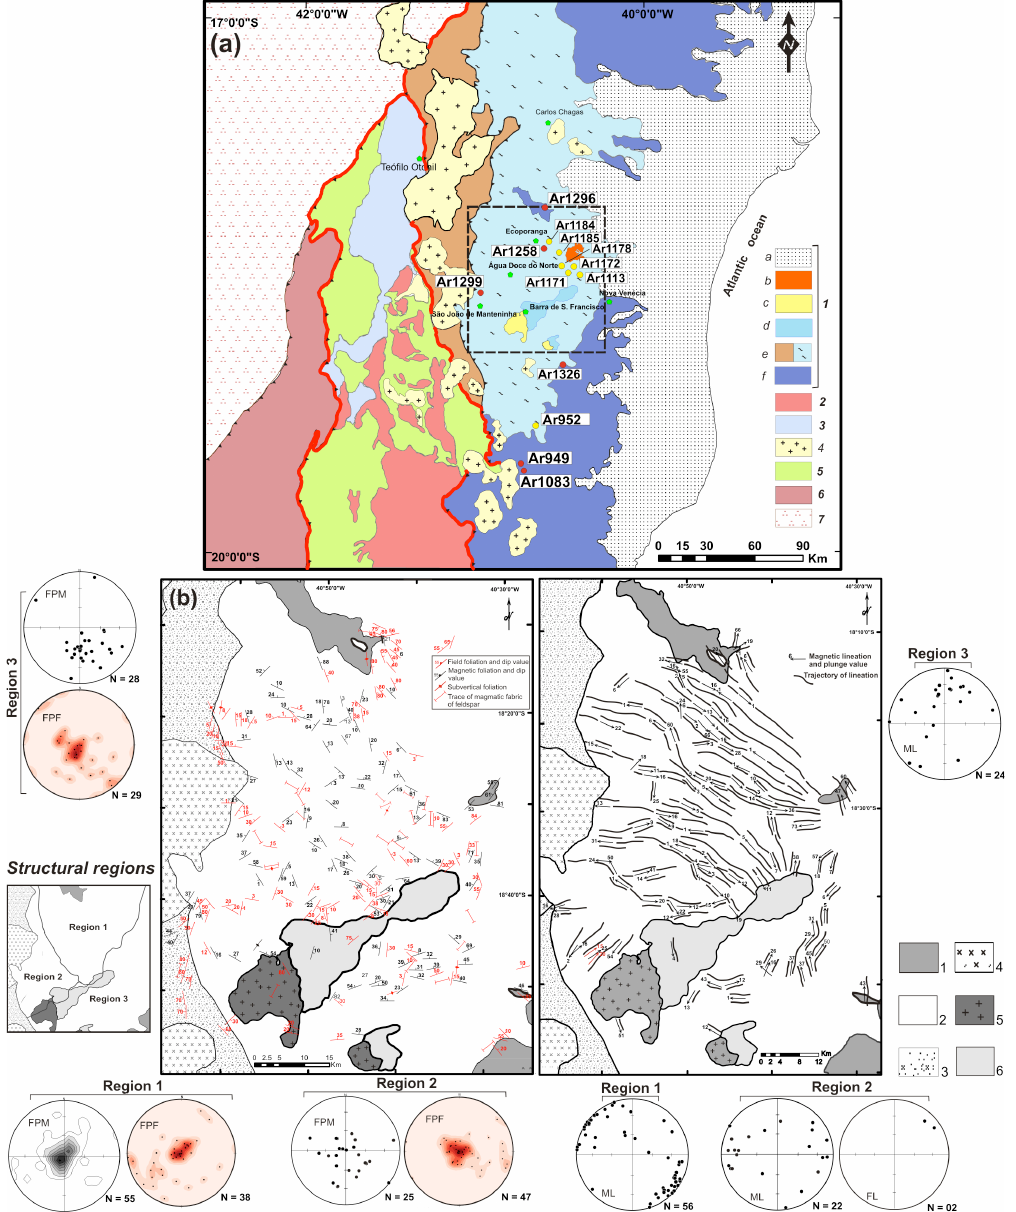
Figure 2. (a) Simplified geological map (after Oliveira et al., 2000 , and Vauchez et al., 2007) showing the main domains of the Araçuaí belt and the location of the samples selected for this study (red = samples analyzed by TitaniQ and yellow = samples of geochemistry analysis): the eastern domain (1) comprises a thick ( > 10km) layer of diatexites, metatexites and anatectic granites (e) associated with migmatitic granulites (f) and intruded on by granite (c) and charnockite (d). (a) and (b) represent the Phanerozoic cover. The central domain comprises a sycollisional magmatic complex (2 = Galiléia batholith; 3 = São Vitor tonalite) intruding in HT metasediments (5). The western domain involves HT metasedimentary mylonites injected by abundant synkinematic leucocratic magma (6) thrust upon the para-autochthonous metasedimentary cover of the São Francisco craton (7). Late orogenic ( ∼ 520Myr, Mondou et al., 2012) porphyritic granitoids associated with charnockites (4) intrude on the stack of allochthonous units. The red line represents the boundary between lithological domains. The green pentagons represent cities. The dashed box shows the location of (b) (structural map showing the AMS and the field measurements across the anatectic domain from Cavalcante et al., 2013): left foliations; the small map on the left shows the three main structural regions as defined by their magnetic lineation pattern. The stereoplots FPM and FPF for each structural region represent the foliation poles obtained from the AMS (k3) and measured in the field, respectively. Right: lineation and lineation traces illustrating the magmatic flow. The ML (k1) and FL stereoplots for each structural region represent the lineation obtained from the AMS and measured in the field, respectively. All the stereoplots are represented in the lower hemisphere of the equal-area projection. 1, 2, 3, 4, 5 and 6 are, respectively, 1f, 1e (Carlos Chagas anatexite), 1e, 4, 1c and 1d of (a)